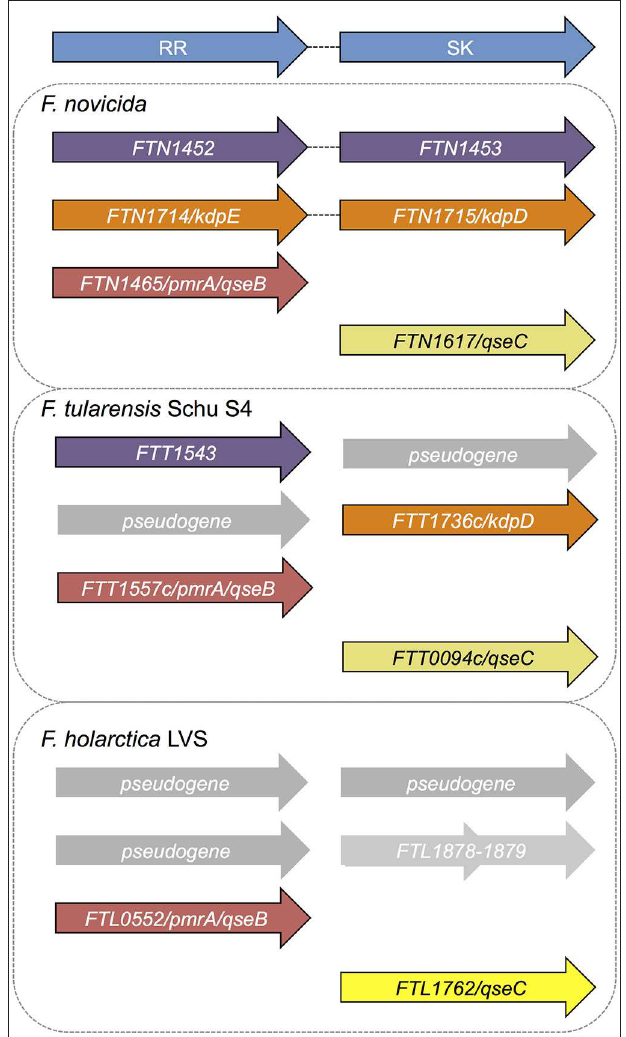
FIGURE 1 | Two component systems annotated or predicted in Francisella species. The fully virulent F. tularensis Schu S4 genome is annotated to contain two sensor histidine kinases and two response regulators, none of which are within intact (paired) two component systems. The two component system genes previously identified in F. tularensis Schu S4 include two sensor kinases FTT_0094c ( qseC ) and FTT_1736c ( kdpD ) and two response regulators FTT_1543 ( bfpR ) and FTT_1557c ( qseB/pmrA ), all of which are considered to be “orphan” or not paired in a canonical two component system operon. In F. novicida , two intact two-component systems are annotated: FTN_1452-FTN_1453 ( bfpR and its paired sensor kinase bfpK ) and FTN_1714-FTN_1715 ( kdpED ). In addition, F. novicida has one orphan sensor kinase FTN_1617 ( qseC ), and one orphan response regulator qseB/pmrA (FTN_1465). The sole response regulator in F. tularensis LVS is FTL_0552 ( qseB/pmrA ) with one orphan sensor kinase, FTL_1762 ( qseC ). Alignment